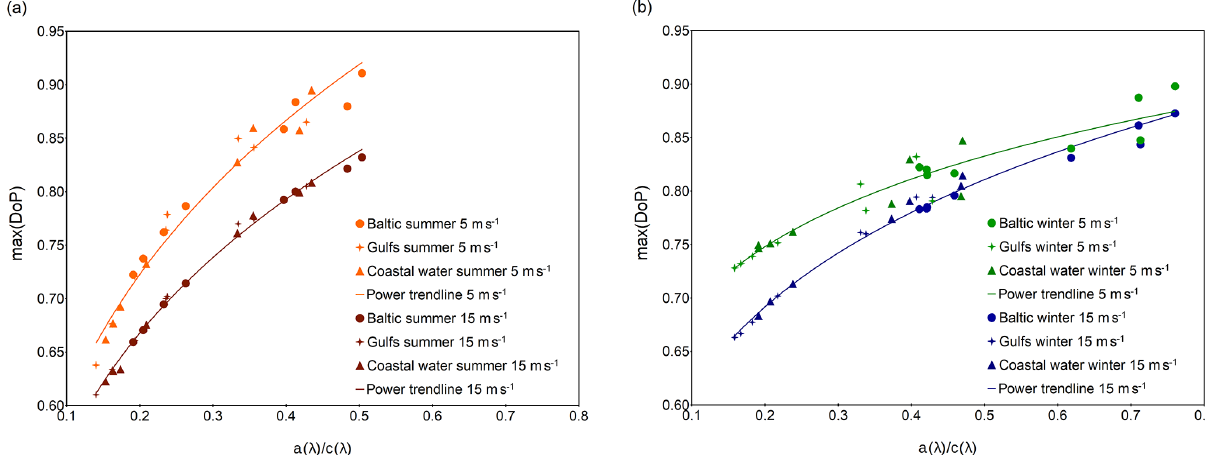
Figure 7. Values of maximum of degree of polarization against absorption-to-attenuation ratios a(λ)/c(λ) for average values of IOPs pre- sented in Table 1, plotted for (a) the summer season and (b) the winter season.